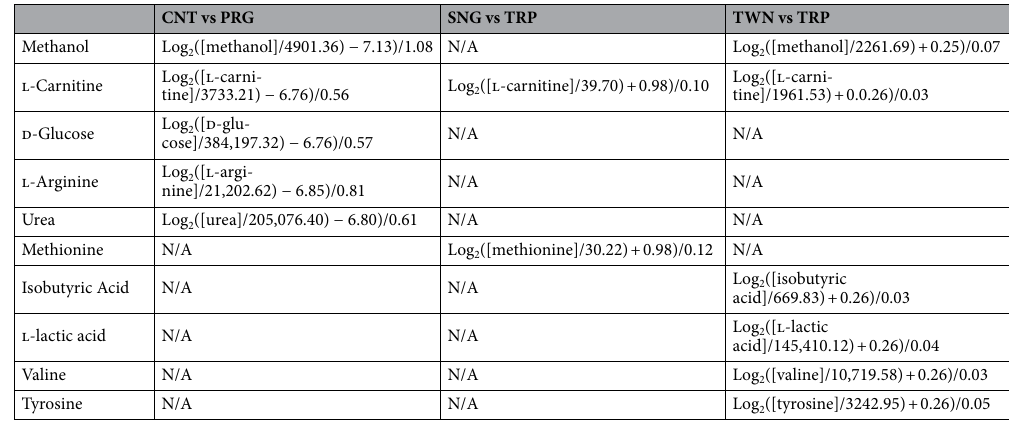
Table 6. Biomarker concentrations adjusted for calculation in the logistic regression. Raw concentration of each metabolite (indicated using square brackets) is converted based on the following formula and the resulting value is used in the corresponding logistic regression